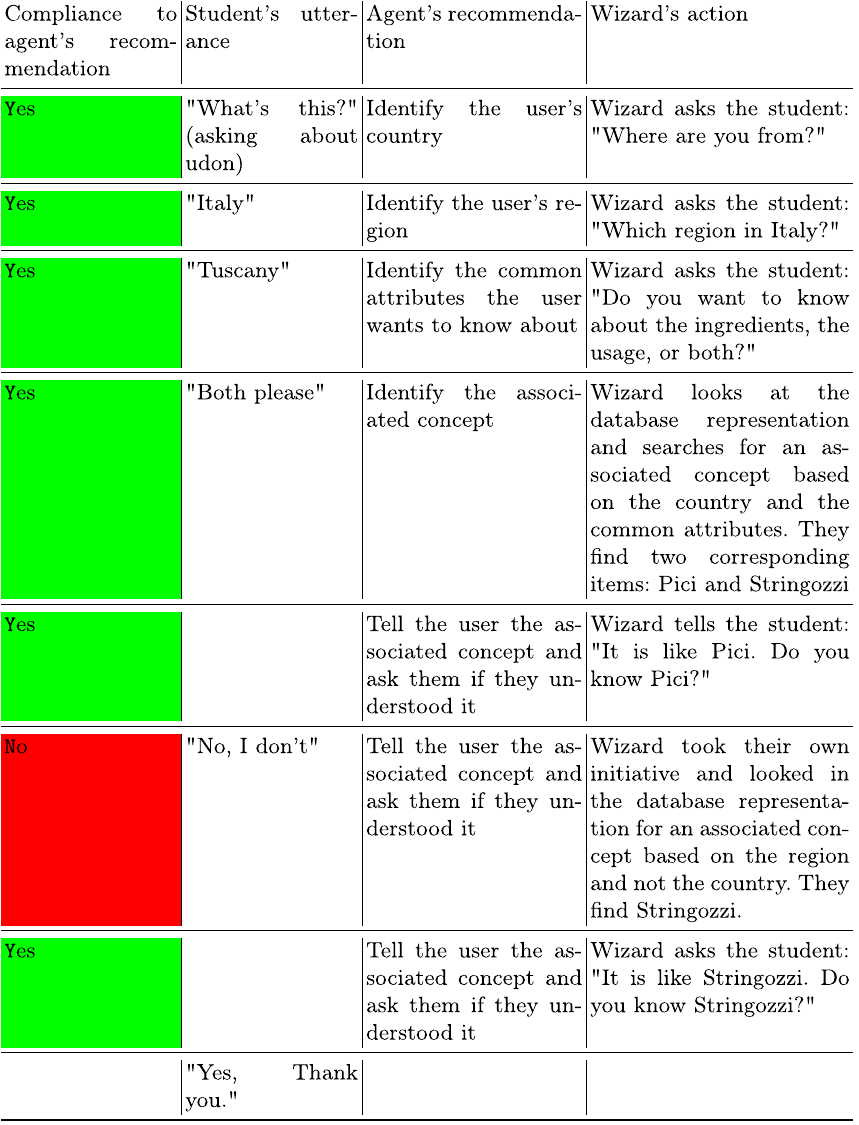
Table 4 Dialogue between the wizard and the intermediate agent and wizard’s compliance to recommendations